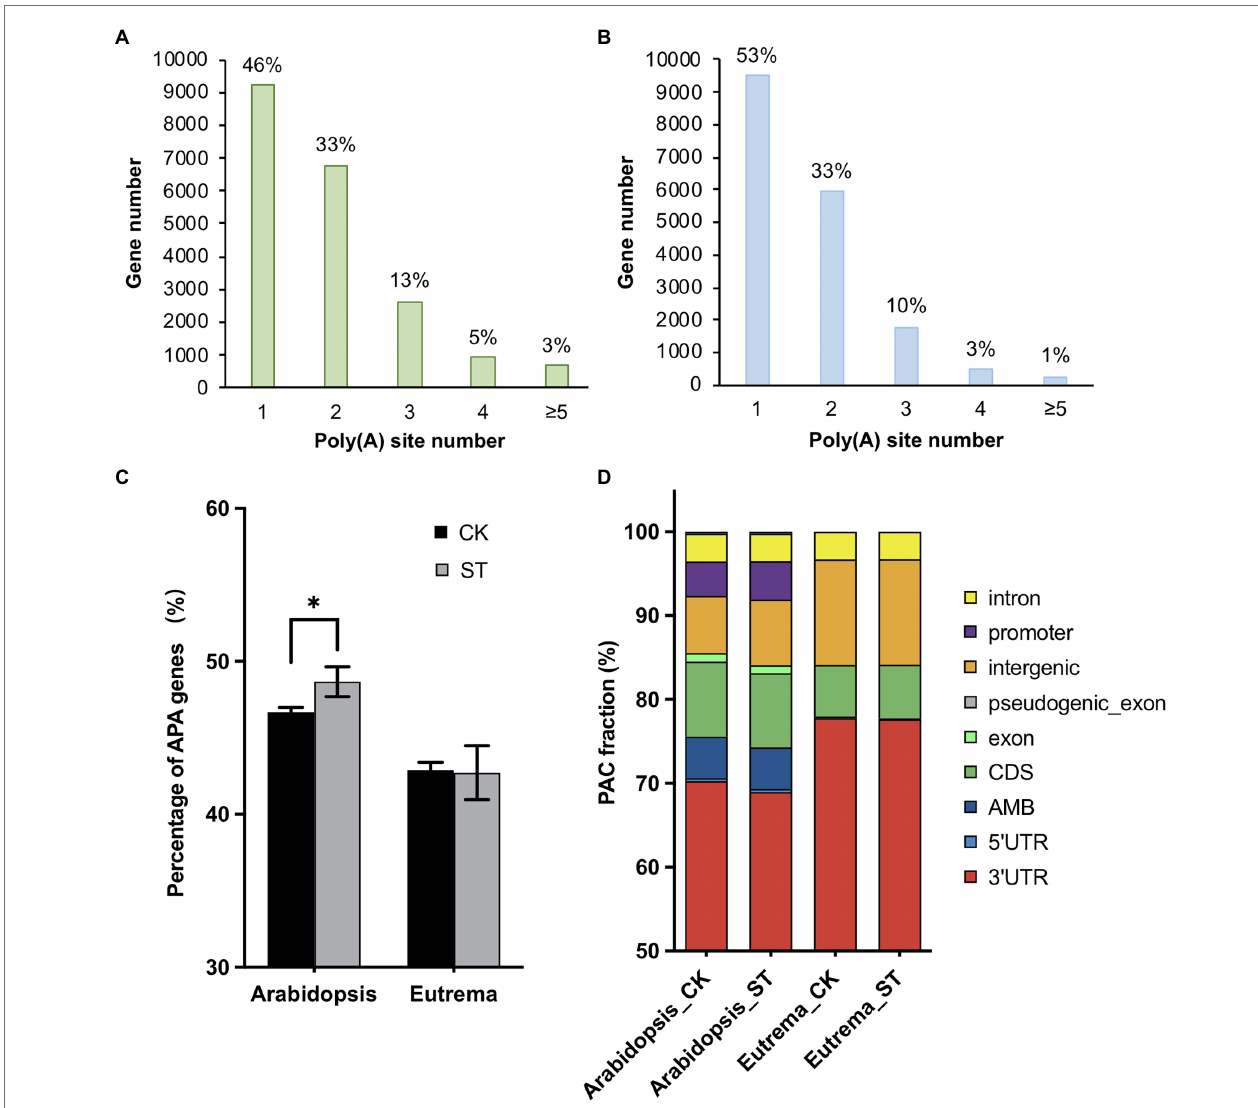
FIGURE 2 | Profiles of the poly(A) sites of Arabidopsis and Eutrema under control and salt stress conditions. (A) Genes and poly(A) sites (per gene) identified in Arabidopsis . The X -axis shows the number of poly(A) sites per gene. Percentages represent gene fractions. (B) Genes and poly(A) sites (per gene) identified in Eutrema . (C) The ratio of alternatively polyadenylated genes (APA genes) in Arabidopsis and Eutrema under control (CK) and salt stress (ST) conditions. Statistical significance was determined by one-way ANOVA, * p < 0.05. (D) Poly(A) cluster (PAC) distribution among different genomic regions in Arabidopsis and Eutrema under CK and ST conditions. AMB: ambiguous PACs assigned to more than one genomic